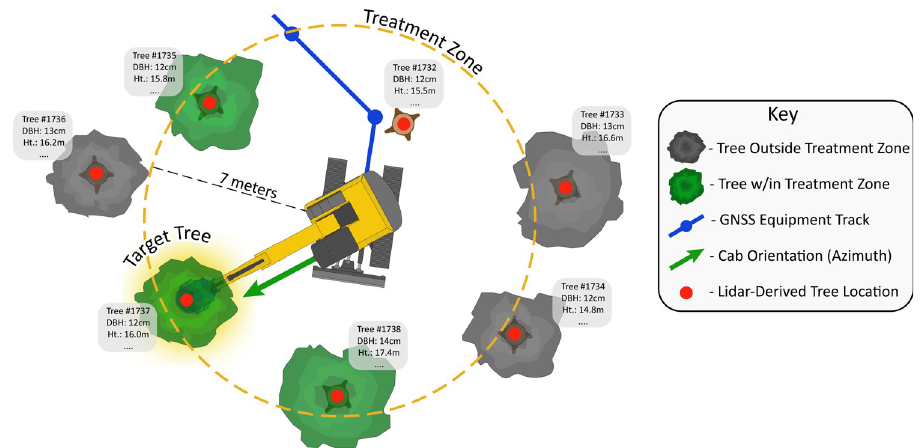
Fig 3. Identifying target trees. Process for identifying potential target trees for mastication using GNSS-RF-based equipment locations, equipment orientation, equipment to tree orientation, and individual tree locations.